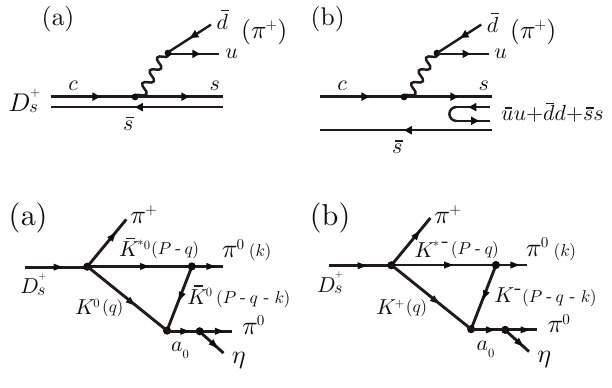
Figure 1. a) Diagrammatic representation of D s → π + ¯ ss . b) Hadronization process through ¯ qq creation with vacuum quantum number. Figure 2. Triangle mechanism which produces π + π 0 a 0 (980). The π + π 0 f 0 (980) channel could be seen replacing π 0 η by π + π − at the end. The momenta of the particles are given in the